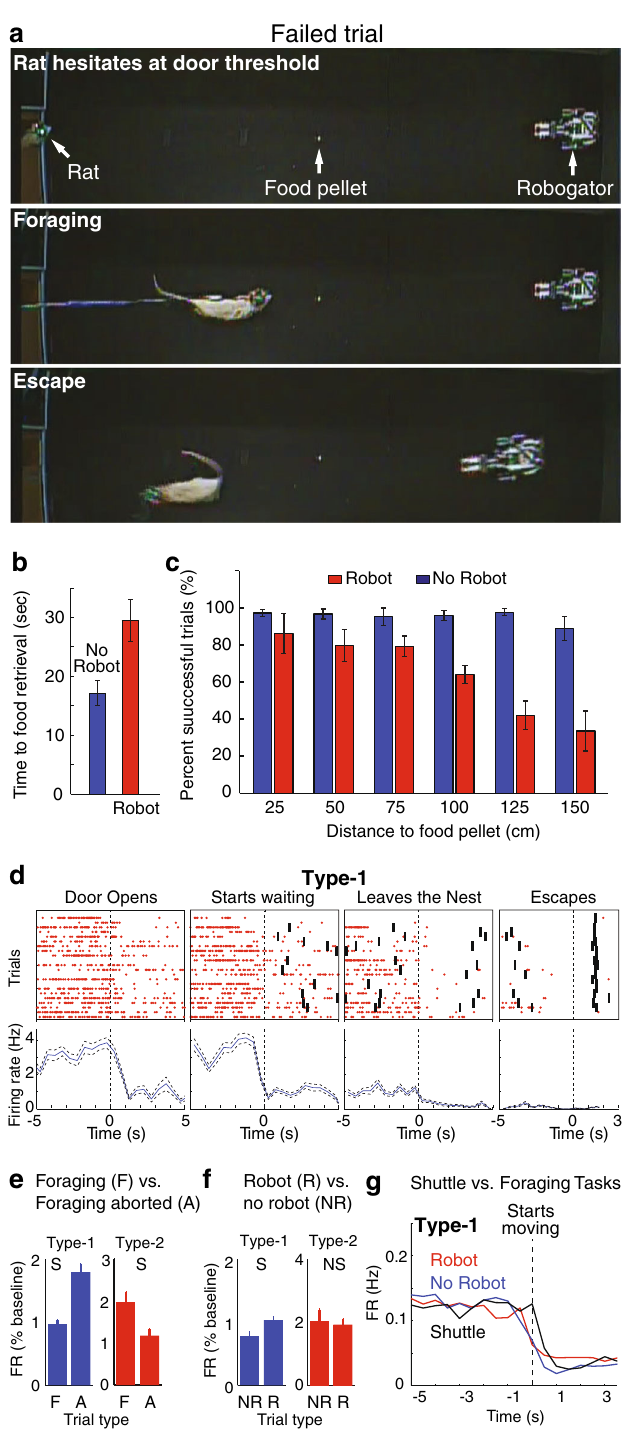
Fig. 1 Foraging task. The foraging apparatus had two compartments divided by a door: a dimly lit nest and a much brighter foraging arena. After training rats to retrieve sweetened food pellets in the absence of Robogator, alternating trial blocks were conducted with or without the Robogator. Each trial started by opening the door. a Example of failed trial. b Time from door opening to food retrieval increases when the robot is present. c Proportion of successful trials is lower when the robot is present. Red , robot present; blue robot absent. d Activity of representative Type-1 cell during the foraging task. Only successful trials are shown. Top rasters ( dots indicate spikes and each line is a trial). Bottom average of all available trials ± SEM. e Normalized FR of Type-1 ( blue ) and Type-2 ( red ) cells during waiting periods preceding initiation of foraging (F) or retreat into the nest (A). f Normalized FR of Type-1 and Type-2 cells during waiting periods in the presence (R) vs. absence (NR) of the Robogator. g FR of Type-1 cell in three conditions: during shuttle task ( black ), or during foraging task with Robot present ( red ) or absent ( blue ). Vertical dashed line indicates initiation of foraging. S signi fi cant, NS non-signi fi cant. Source : Ref.